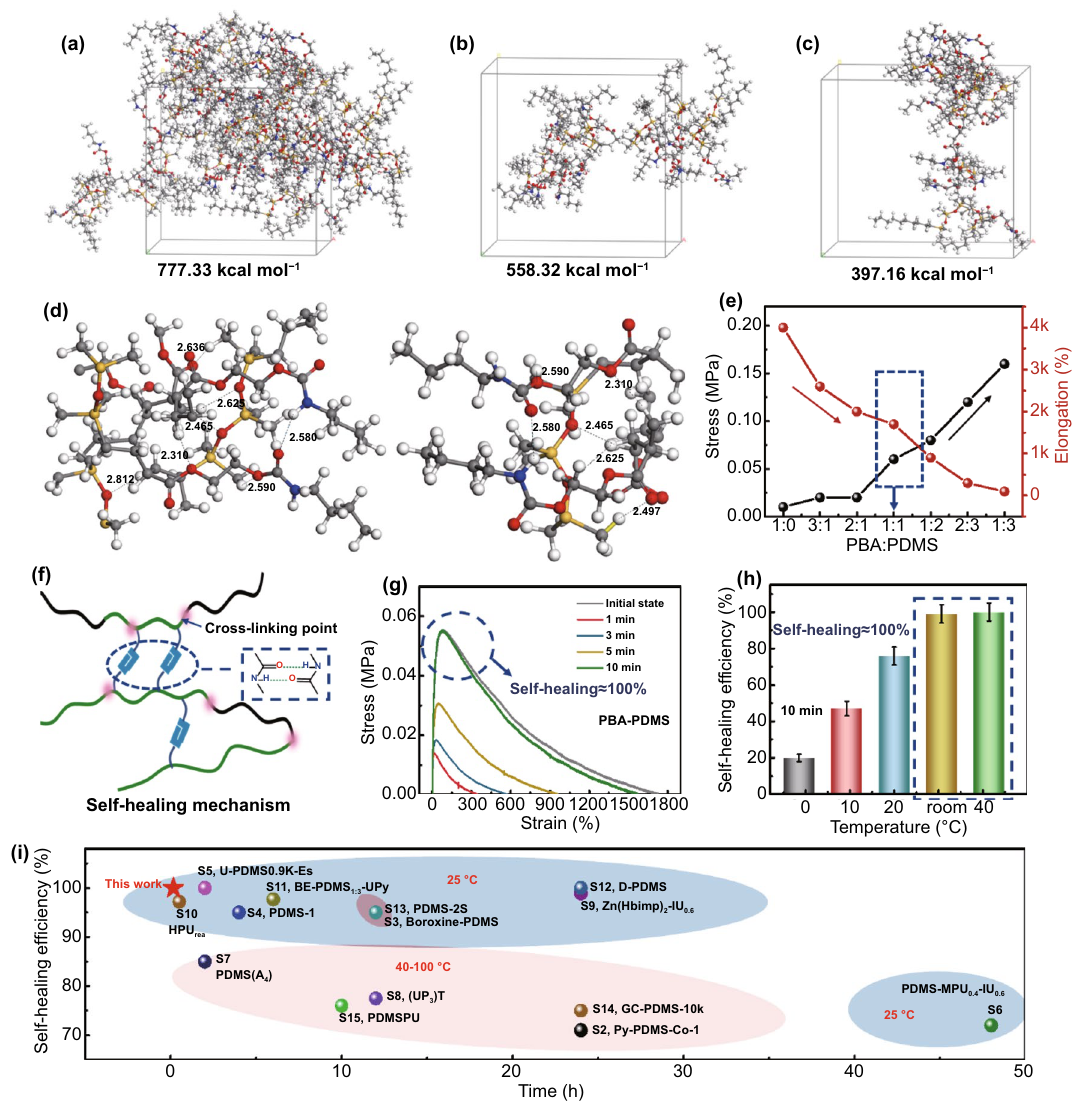
Fig. 2 a Single point energy model for PBAx–PDMS. b, c Model for two chains with more forces in PBAx–PDMS. d Hydrogen bonding inter- actions between copolymers. e Strength and elongation of PBAx–PDMS for different molar ratios of PBA and PDMS. f Self-healing of polymer segments. g Stress–strain curves of the PBA–PDMS at room temperature for different self-healing durations (1, 3, 5, and 10 min). h Self-healing efficiency of PBA–PDMS at different temperatures (0, 10, 20, 25, and 40 °C) for 10 min. i Comparison of the self-healing efficiencies of the reported polymer with